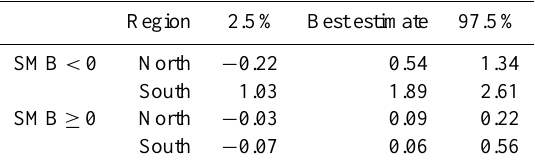
Table 3. The 2.5% quantile, best estimate, and 97.5% quantile estimates of the SMB–elevation gradients in kgm − 3 a − 1 , below (SMB < 0) and above (SMB ≥ 0) the ELA, for regions north and south of 77 ◦